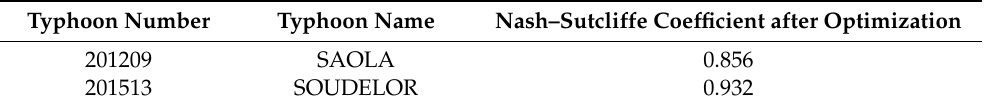
Table 7. Parameter optimization results of the HEC-HMS of the study